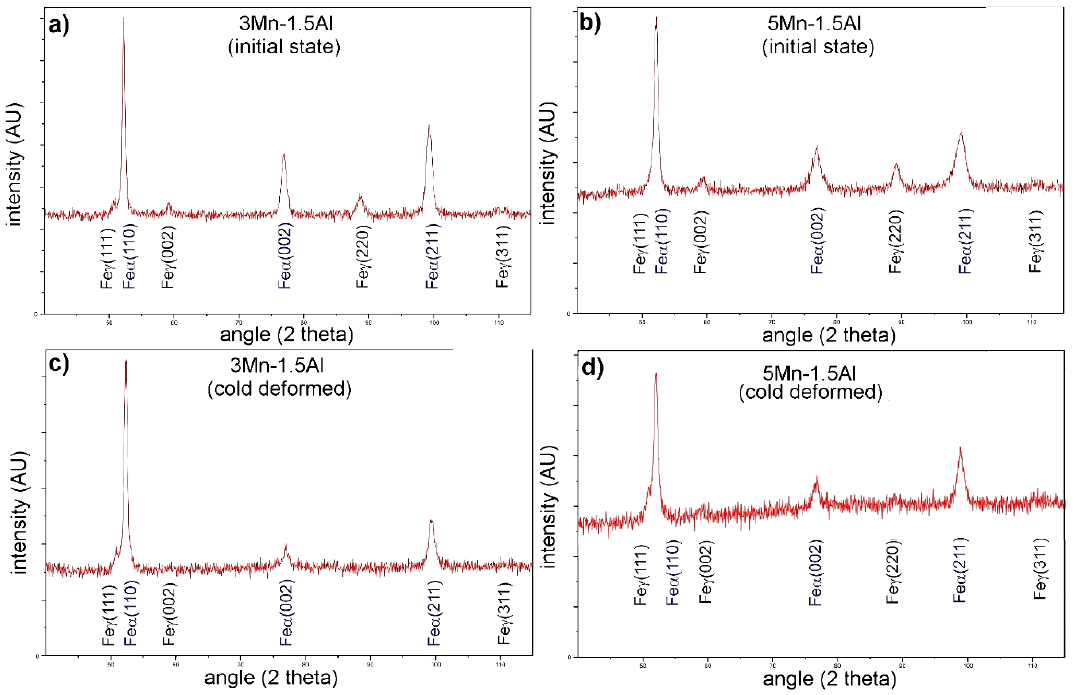
Figure 5. X-ray diffraction patterns of: ( a ) 3Mn-1.5Al steel, ( b ) 5Mn-1.5Al steel at the initial state, ( c ) 3Mn-1.5Al steel, ( d ) 5Mn-1.5Al steel after static tensile tests (cold deformed).